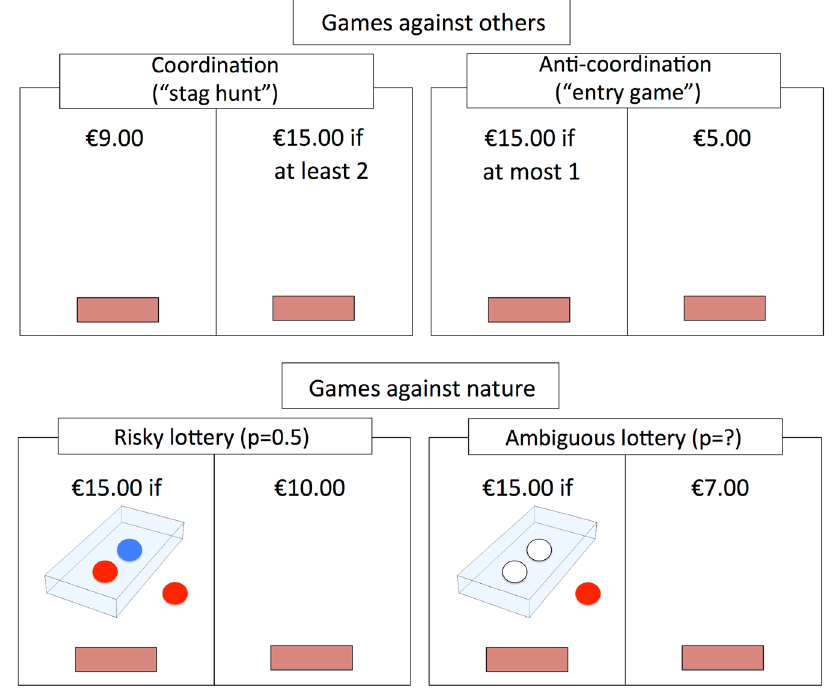
Figure 1. Experimental design. Sample screens for each of the four decision environments in which participants chose between a low paying but safe option (a safe option, e.g., “SP”) and an option worth more or nothing (thus an uncertain option, “UP”), depending on a risky or uncertain outcome. The UP was always worth €15.00 or €0, while the value of the SP varied from trial to trial (covering the whole range between 0 and €15.00 equally for each environment). Top row: “games against others” involved one of two coordination games, in which the outcome of the uncertain option depended on the choice of another player. Left: a coordination game (a “stag hunt”), in which both participants could obtain the highest payoff by both choosing the UP option. However, if one chose the UP alone, he/she earned nothing. Right: an anti-coordination game (an “entry game”), in which participants could only obtain the high payoff if they chose the UP option but their counterpart did not. If both chose the UP, both earned nothing at all. Bottom row: “games against nature” involved one of two lottery extractions, in which the outcome of the risky or uncertain option depended on an extraction from a real urn. Left: in a risky lottery condition, the probability of winning was known (and occurred with a probability of 0.5). Right: in an ambiguous lottery condition, the probability of winning was unknown.